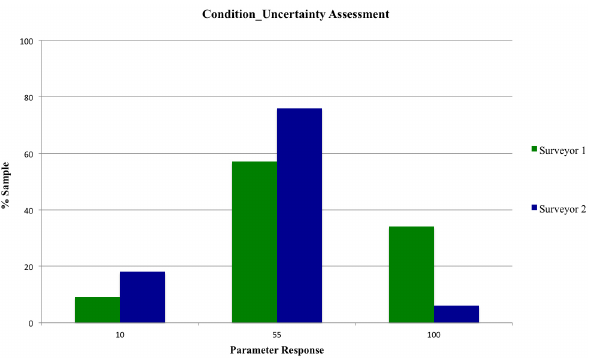
Fig. 11. Comparison of survey responses for conditions, to deter- mine uncertainty within